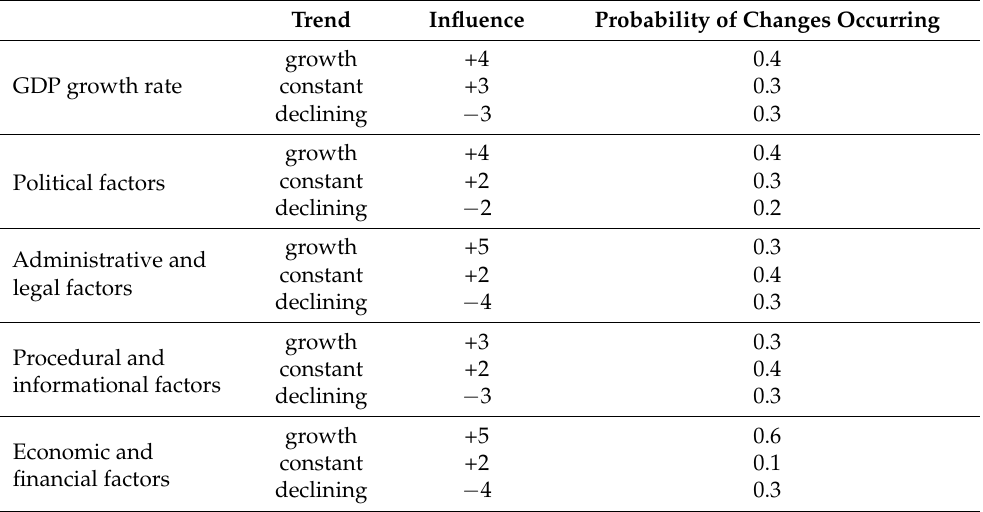
Table 3. Assessment of the factors influencing the development of energy from renewable sources.